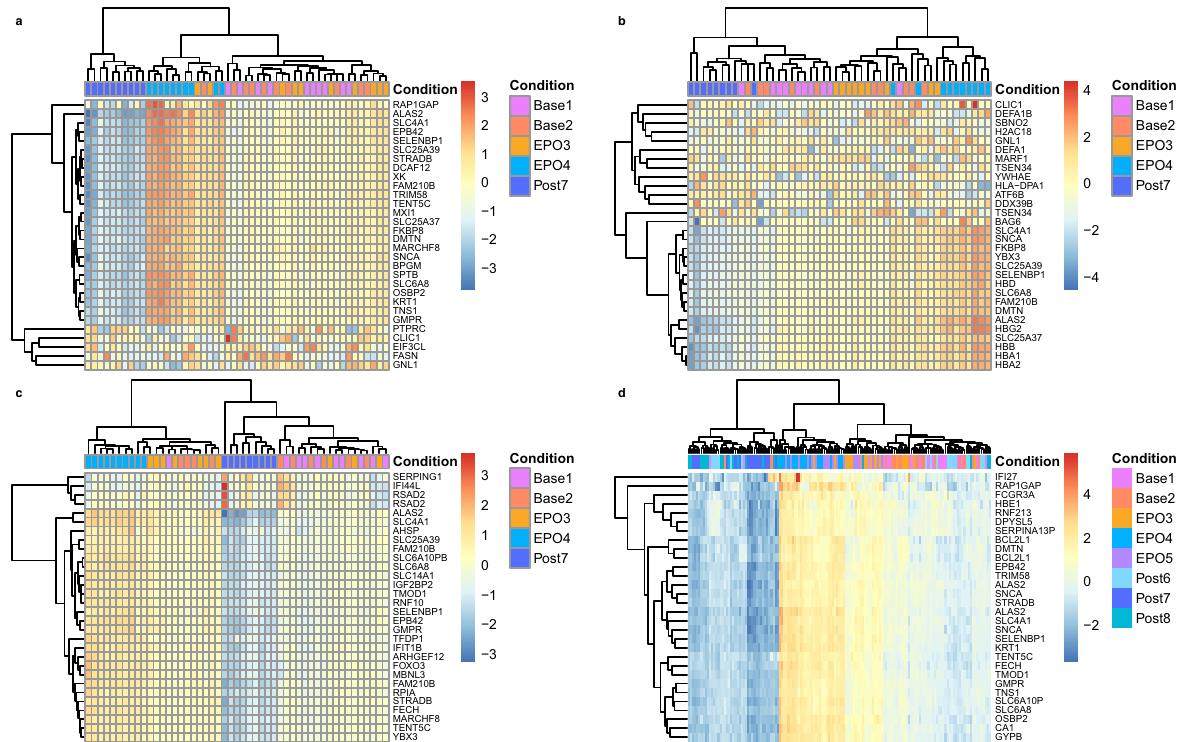
Figure 1. Gene clustering analysis of the top 30 genes of high variance across the RNA-seq and the microarray platforms. ( a ) MGI DNBSEQ-G400RS, ( b ) Illumina NextSeq 500; ( c ) GeneChip HTA2.0; ( d ) Illumina HumanHT-12 v4 Expression BeadChip.